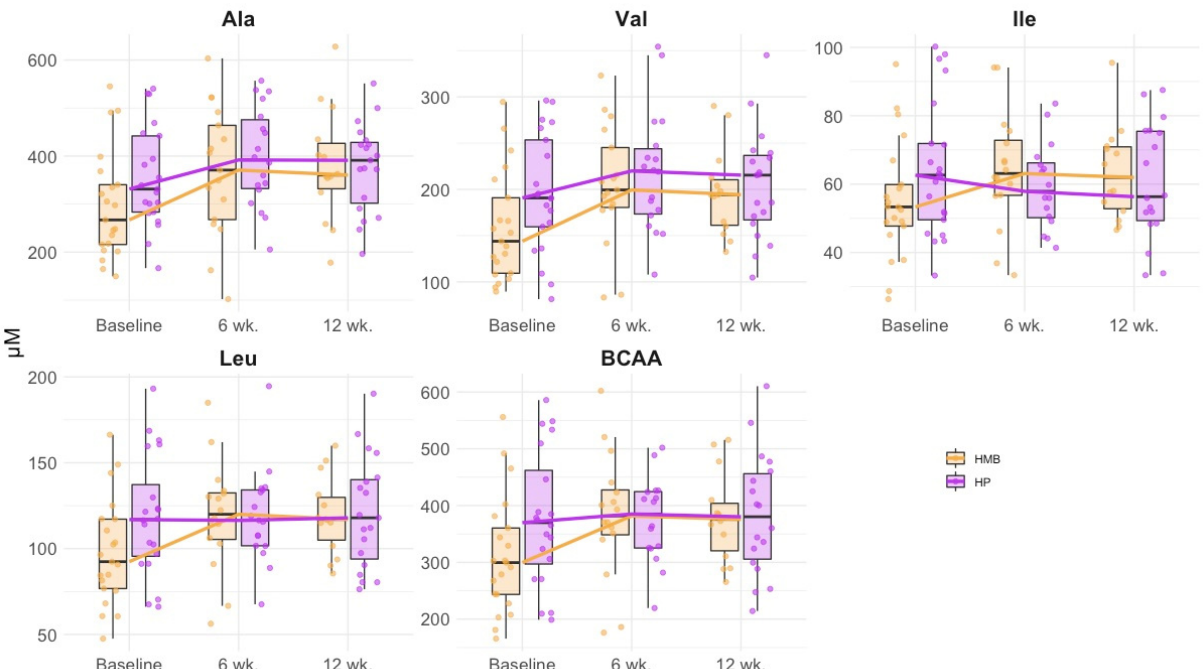
Figure 2. Plasma amino acid variations during follow-up in all cirrhotic patients according to treatments. HMB: HMB group, HP: High Protein groups. BCAA: branched chain amino acids. Each point represents a single subject. Boxes are drawn from Q1 to Q3 with a horizontal line drawn in the middle to denote the median.